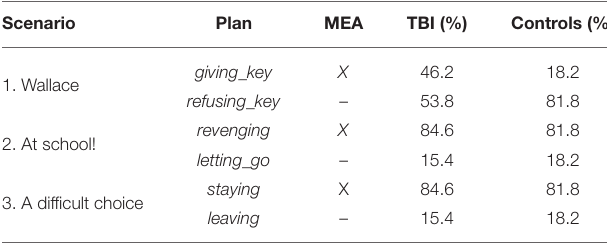
TABLE 1 | Actor studio: percentages for action choice. Scenario